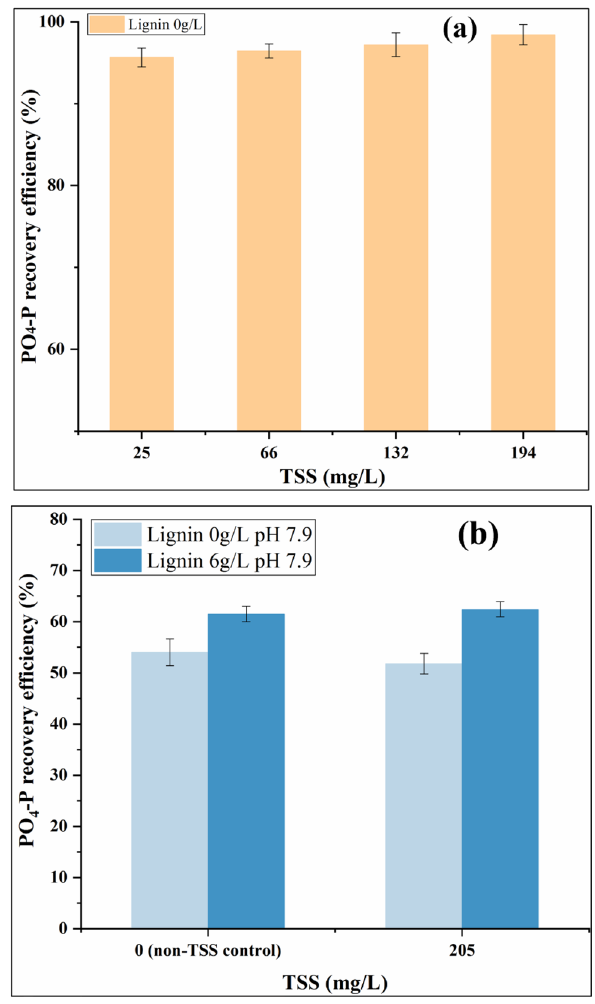
Figure 7. Impact of total suspended solids (TSS) on PO 4 –P recovery efficiency for ( a ) real biosolid digestate supernatant, ( b ) synthetic biosolid digestate supernatant (Mg/P molar ratio = 1.5, [PO 4 –P] = 250 mg/L, [NH 4 –N] = 1000